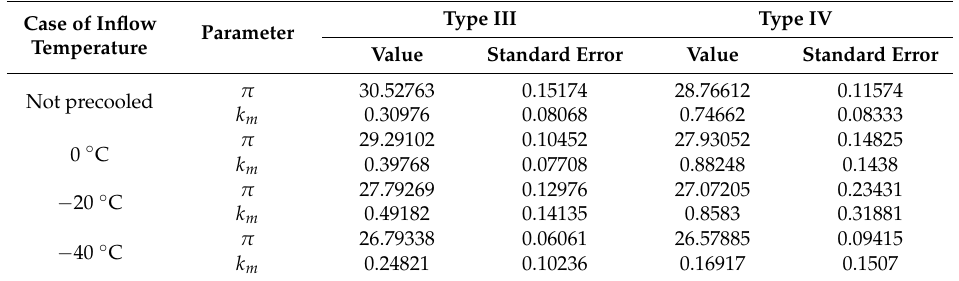
Figure 2. Effect of mass flow rate (unit g/s is used here for expressing source data of fitting) on SOC under different inflow temperatures (unit ° C is used for expressing experimental condition) for ( a ) Type III tank and ( b ) Type IV tank (Symbol: data [14], Line: fitting). Table 2. Parameter values for effect of mass flow rate on SOC under different inflow temperatures.